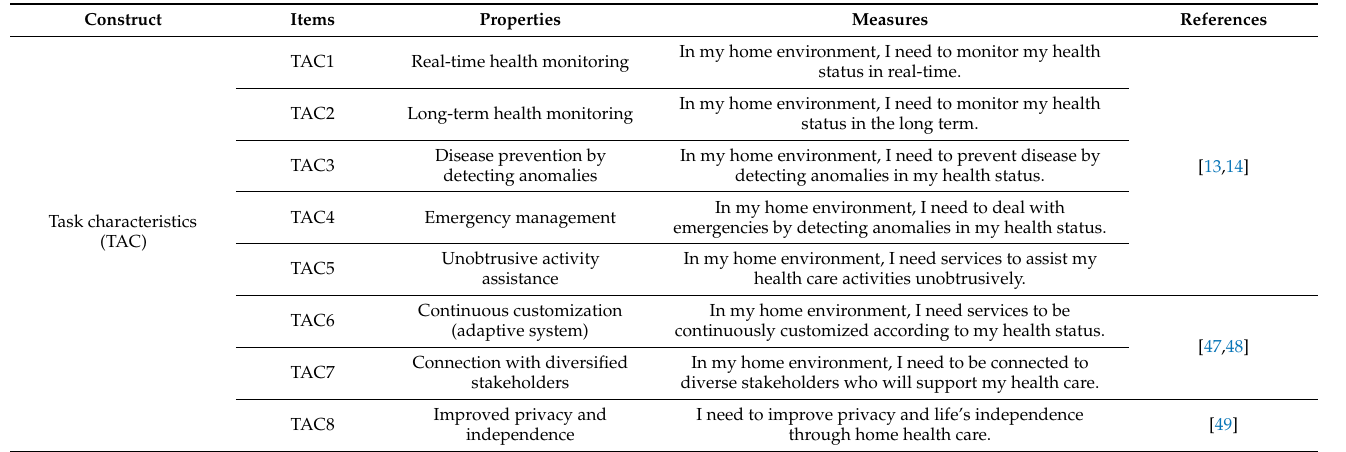
Table 2. Measurement items and the sources of